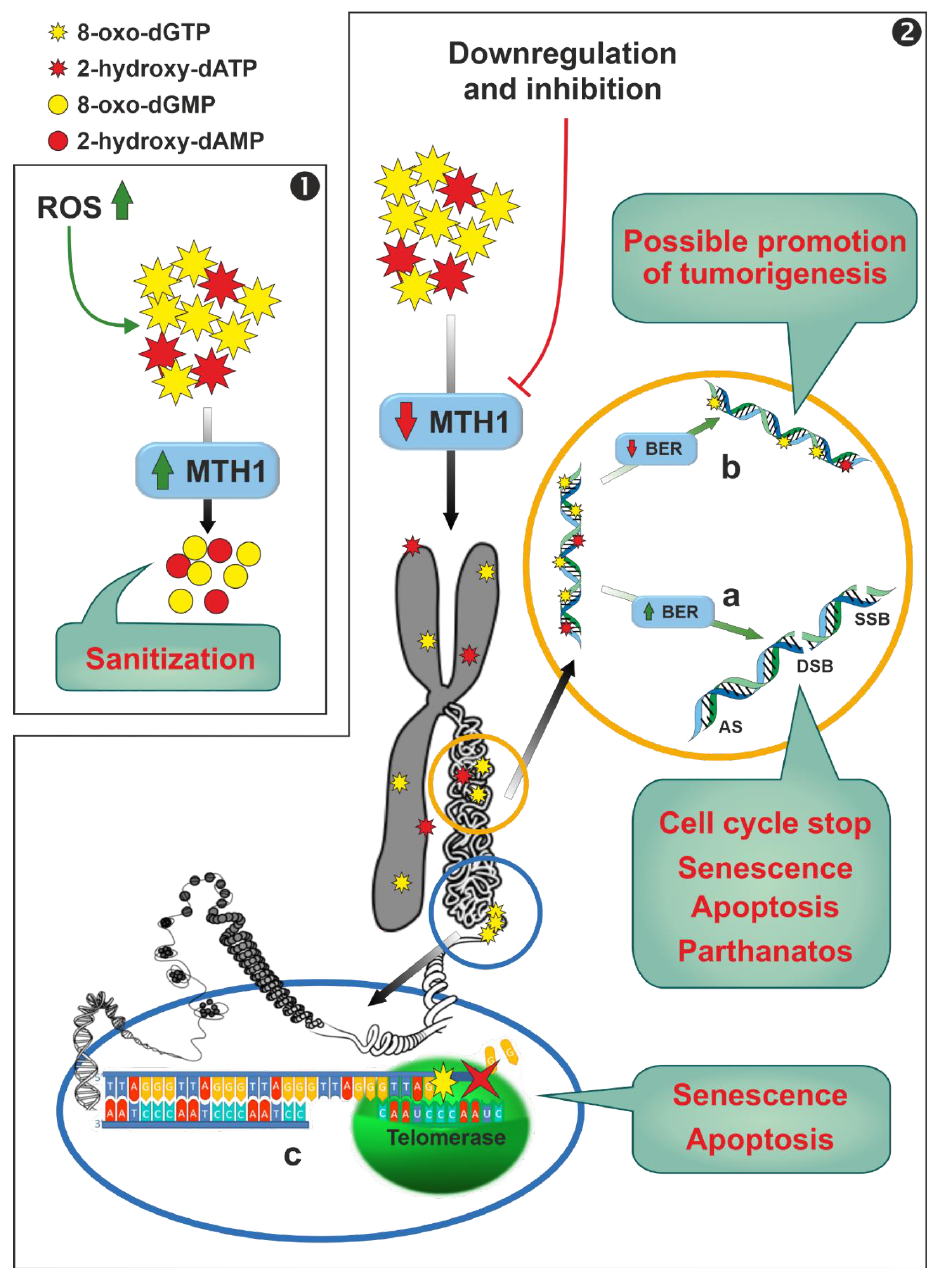
Figure 6. Scheme of possible effects of therapeutic use of human MutT homolog 1 ( MTH1). Panel 1: Cancer cell proliferation is stimulated by the accumulation of ROS, which favours the formation of 8-oxo-dGTP and 2-hydroxy-dATP. In order to avoid the potentially toxic effects of the incorporation of oxo-derivatives of nucleotides, the cells upregulate MTH1 sanitizing enzyme. Panel 2: downregulation or inhibition of MTH1 leads to an abnormal incorporation of oxidised nucleotides in DNA. Panel 2a: in order to deal with this excessive accumulation of oxo-nucleotides in DNA, the base excision repair (BER) system is, in general, upregulated. If the misincorporation of oxo-nucleotides exceeds the capability of BER, abasic sites (AS) or single strand brakes (SSB) or double strand brakes (DSB) accumulate, leading to several serious consequences. Panel 2b: if BER is downregulated, incorporated oxo-nucleotides are not repaired. In this case no cytotoxic e ff ect is reported, but a promotion of tumourigenesis can occur. Panel 2c: the misincorporation of 8-oxo-dGTP by telomerase into the repeated telomeric sequence TTAGGG leads to the inhibition of the polymerase activity of the